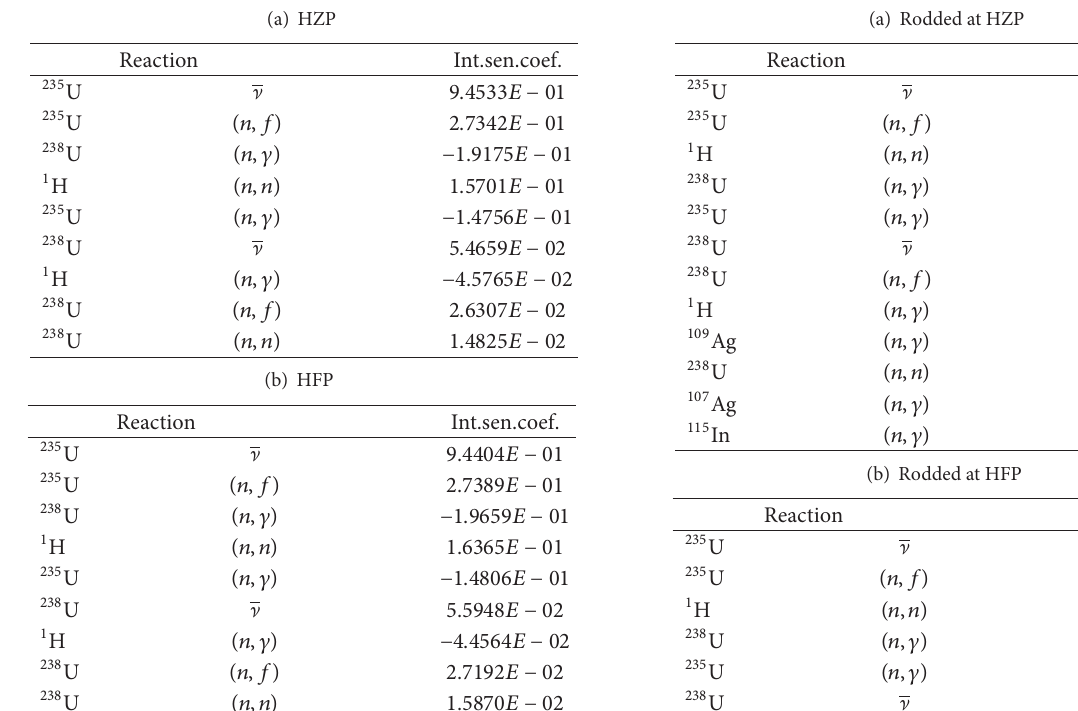
Table 5: Largest integrated sensitivity coefficients of the reaction cross sections for the unrodded case at HZP and HFP sorted in descending order provided by SCALE-6.1.